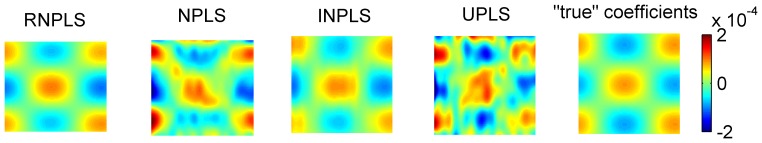
The RNPLS, NPLS, INPLS, UPLS and “true” regression coefficients.Comparison of the regression coefficients averaged over 10 realizations of noise in the simulated dataset (level of noise 1000%). RNPLS, NPLS, INPLS, UPLS and “true” coefficients.